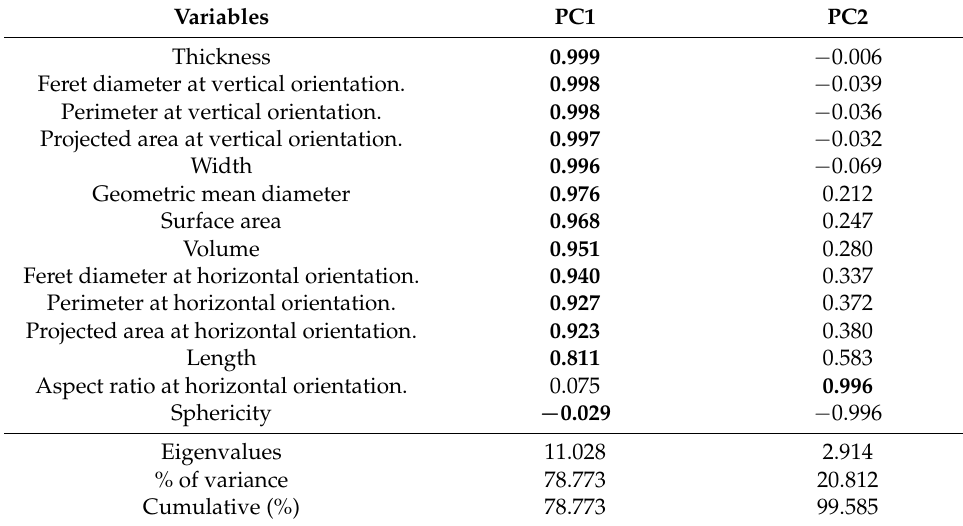
Table 5. Eigen statistics for two principal